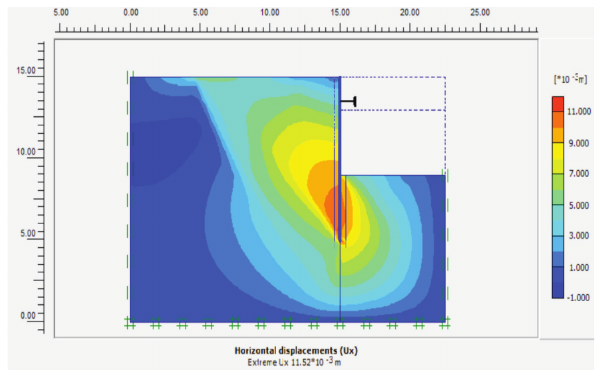
Figure 3: Maximum lateral deflection of diaphragm wall panel as per EC 7(D1 B).